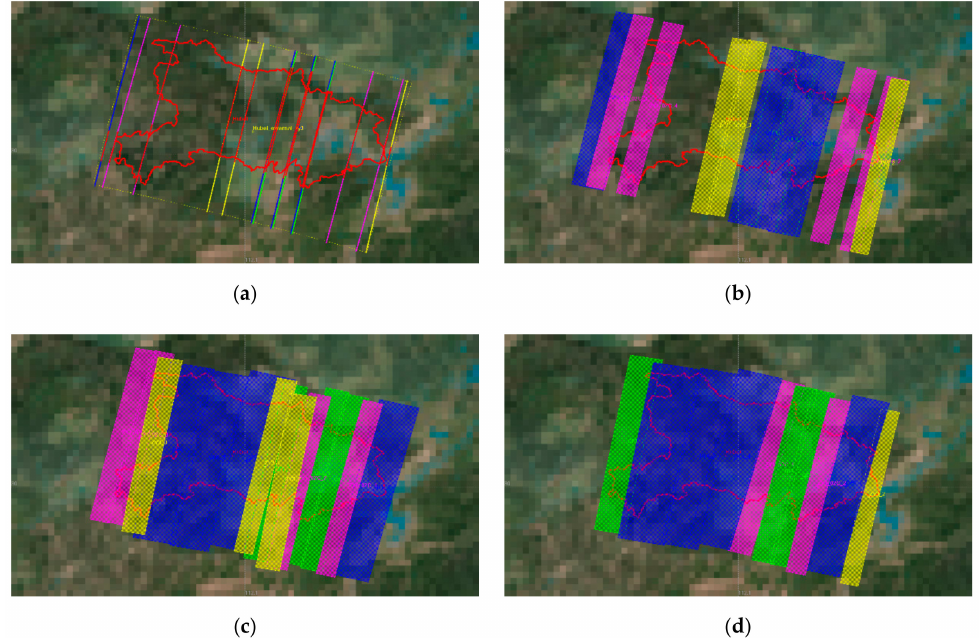
Figure 7. Mission planning results obtained using di ff erent modeling methods in Hubei. ( a ) Satellite trajectories; ( b ) satellite vertical imaging results without optimization; ( c ) satellite optimized imaging results when the model has only one objective function; and ( d ) satellite optimized imaging results when the multi-objective modeling method proposed in this paper was used.